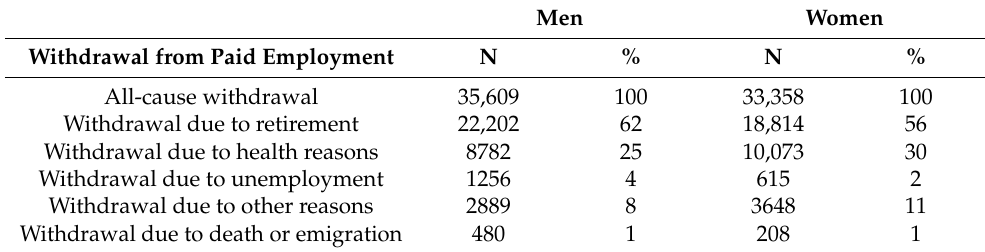
Table 2. Distribution of cause-specific withdrawal among persons born between 1949–1953 who were in paid employment in Norway at age 62 and who withdrew from paid employment during the follow-up period 2011–2016 (N =